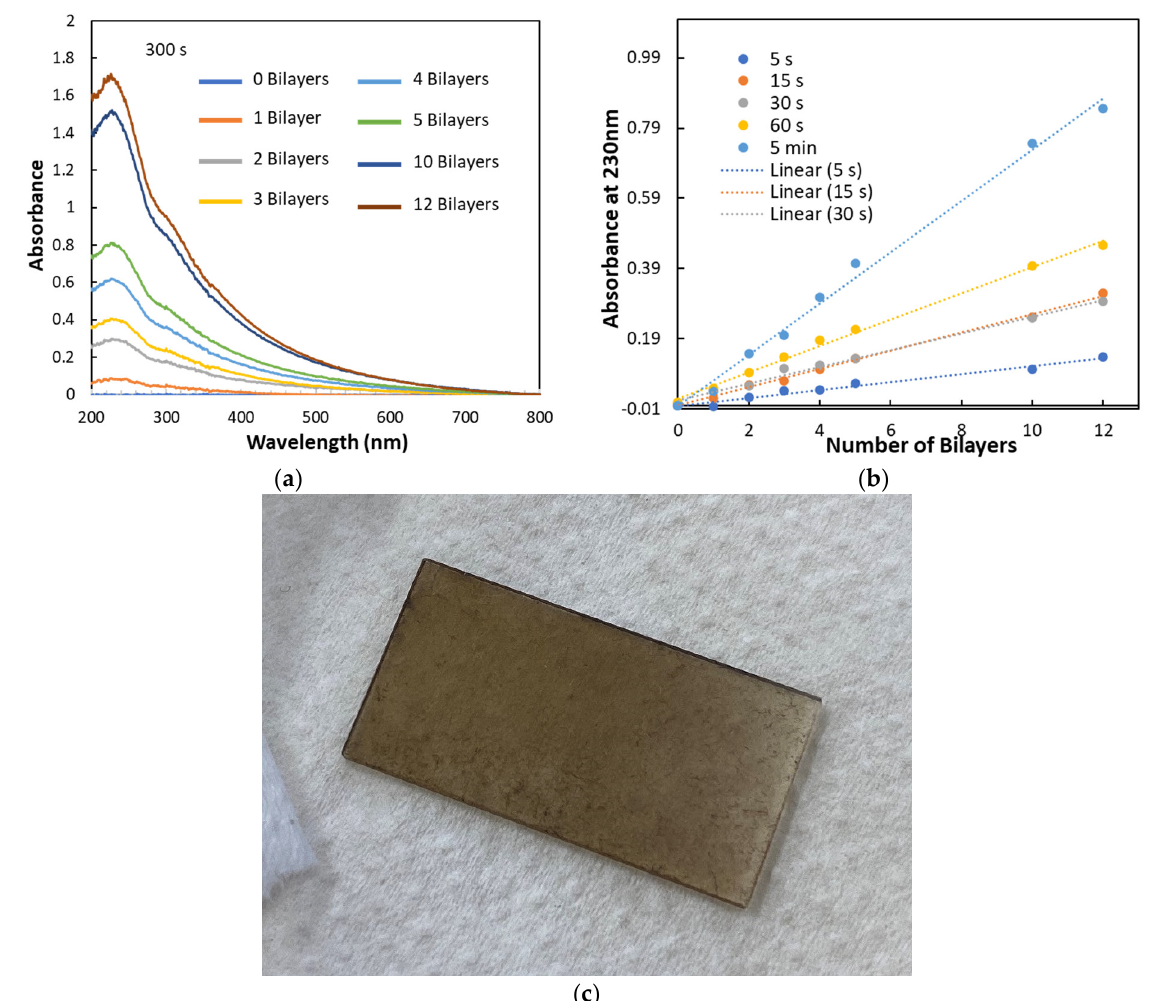
Figure 2. ( a ) Absorbance spectra of PEI/GO LbL films with different numbers of bilayers prepared with 300 s of adsorption time for each layer; ( b ) absorbance at 230 nm as a function of the number of bilayers of PEI/GO LbL films prepared with different adsorption time periods, namely 5, 15, 30, 60 and 300 s; and ( c ) image of a (PEI/GO) 12 LbL film prepared with an adsorption time of 60 s. The area of the quartz solid substrate where the film is deposited was 13 × 26 mm 2 .